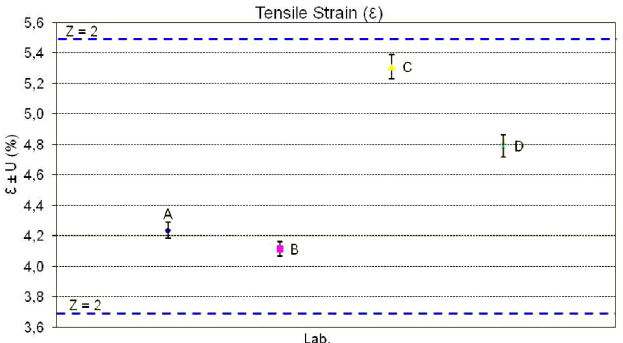
Fig. 4. Tensile strain ( ε ) and uncertainty values for tensile test of the participant laboratories.